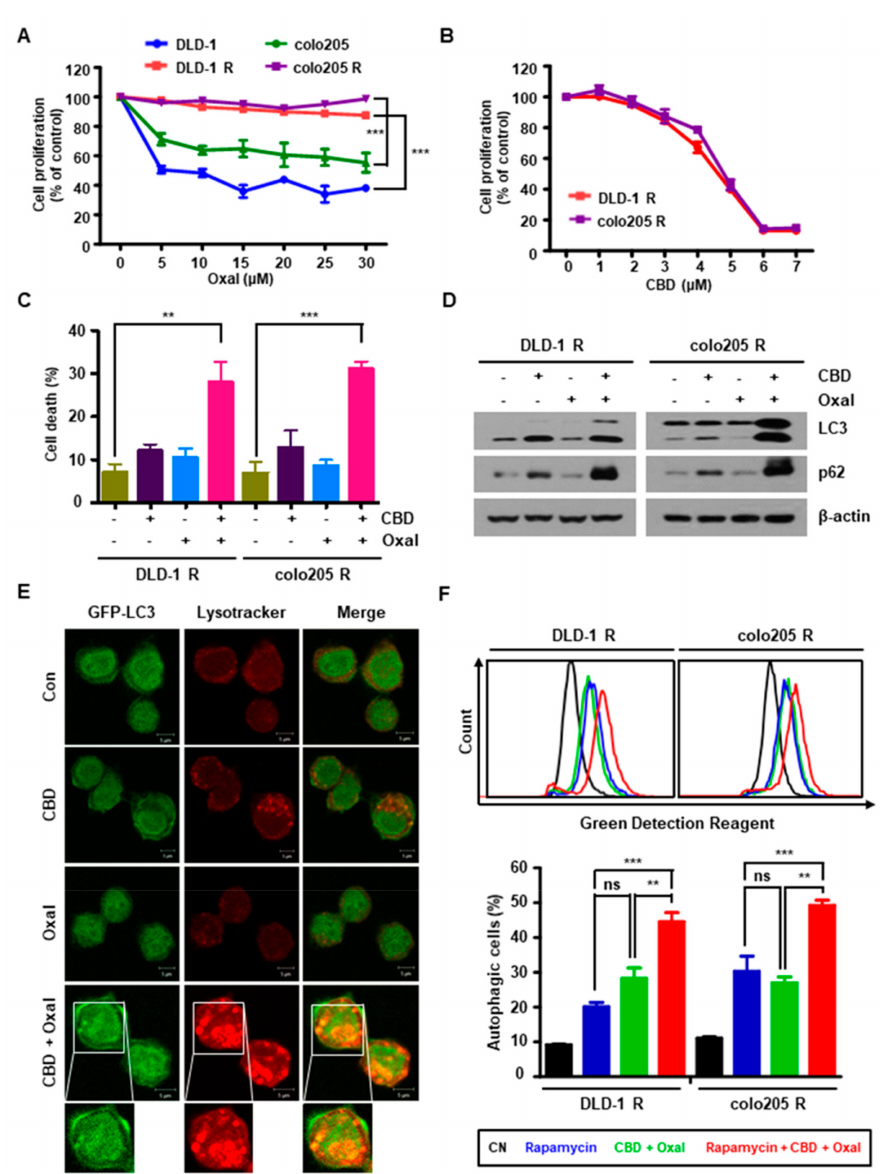
Figure 1. Combination of oxaliplatin and cannabidiol (CBD) reduces cell proliferation and induces autophagy in oxaliplatin-resistant colorectal cancer (CRC) cell lines. ( A , B ) Parent (DLD-1, colo205) and oxaliplatin-resistance CRC cell lines (DLD-1 R, colo205 R) were treated with 0–30 µ M ( A ) oxaliplatin ( B ) or CBD for 24 h. Cell proliferation was measured by 4-[3-(4-lodophenyl)-2-(4-nitrophenyl)-2H-5-tetrazolio]-1,3-benzene disulfonate (WST-1) assay. *** p < 0.001. ( C ) After oxaliplatin and CBD treatment, viable oxaliplatin-resistant cells were identified by Trypan blue staining. ** p < 0.01 and *** p < 0.001. ( D ) Cells were treated with 4 µ M CBD and 10 µ M oxaliplatin for 24 h. The levels of LC3 and p62 were determined by western blotting. ( E ) The formation of green fluorescent protein (GFP)-LC3 puncta after treatment with oxaliplatin and CBD was analyzed by confocal microscope (scale bar, 5 µ m). ( F ) Cells were treated with oxaliplatin and CBD for 12 h following pretreatment with 1 µ M rapamycin for 1 h and then stained with an Autophagy Detection Kit for 30 min at 37 ◦ C in the dark. Cells were harvested and analyzed by flow cytometry (upper). The graph represents the quantification of autophagic cells (lower). ** p < 0.01 and *** p <